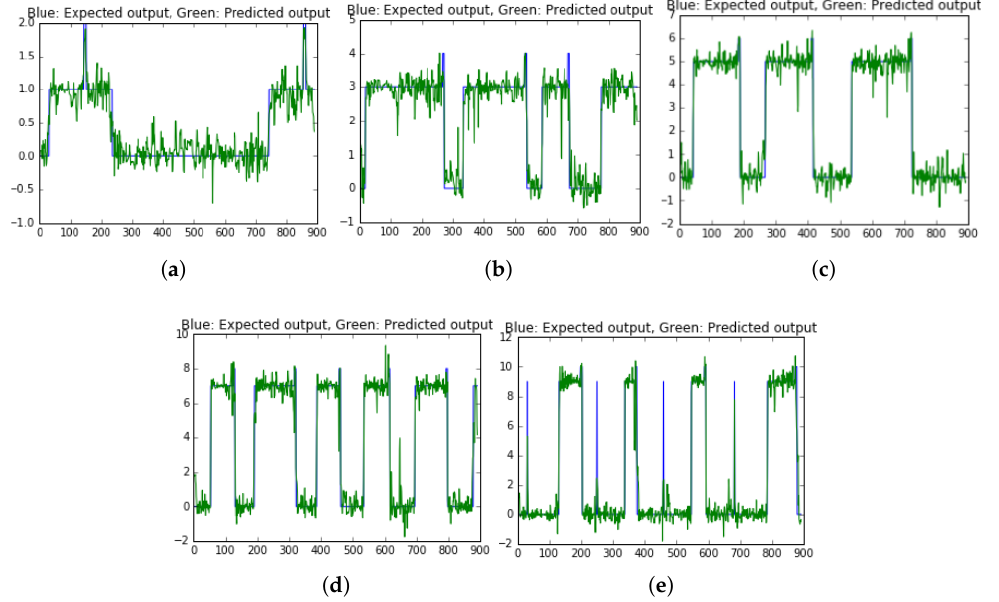
Figure 15. Classification results of LSTM model on 5 appliances data: ( a ) Airpurifier device; ( b ) Fan device; ( c ) Hairdryer device; ( d ) LG monitor device; ( e ) Samsung monitor